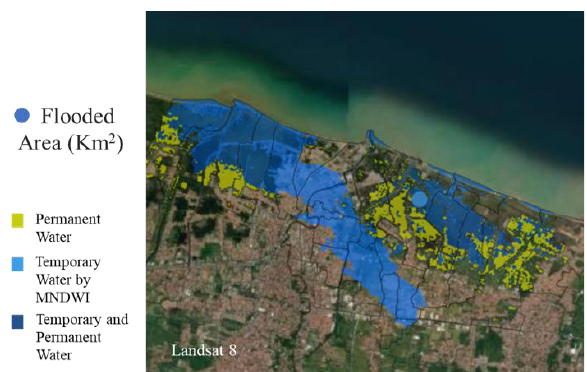
Figure 10. Flooded area in Pekalongan Northern Coast In addition to that, the study also developed the damage analysis by considering the property is affected and the population exposed (Figure 11). Property damage is defined as the GDP loss in the flooded area boundary. While the population exposed is defined as the total inhabitant living in the region where floods occur. The damage analysis used Open Street Map (OSM) and Gridded GDP. The plan will consider the depth, duration, and GDP. While the population exposed was calculated using gridded WorldPop. We found that the main issue was the spatial resolution.